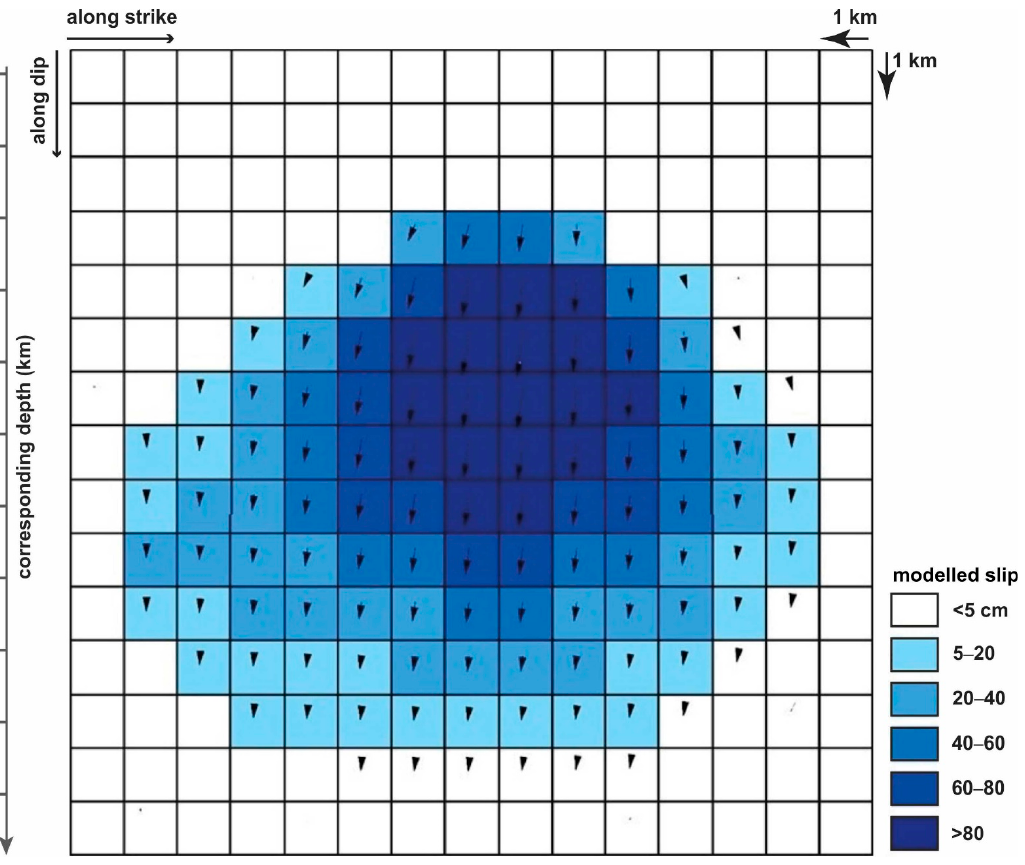
Figure 8. M L 5.8 main event slip distribution. The top of the modelled area is placed at a depth of 1.6 km. Arrows indicate the slip direction at each cell.